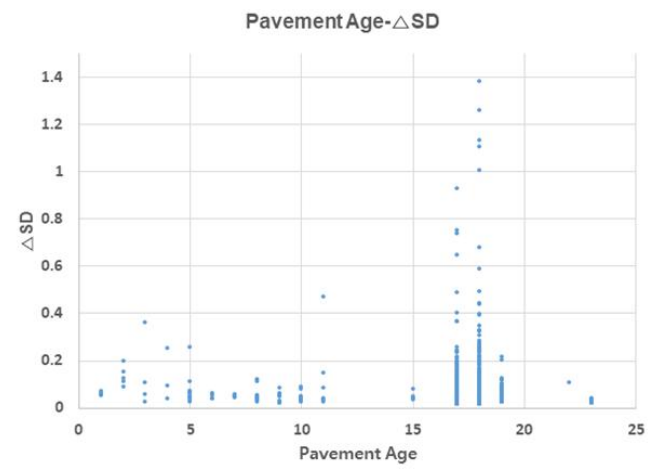
Figure 9. Pavement age–ΔSD relationship.